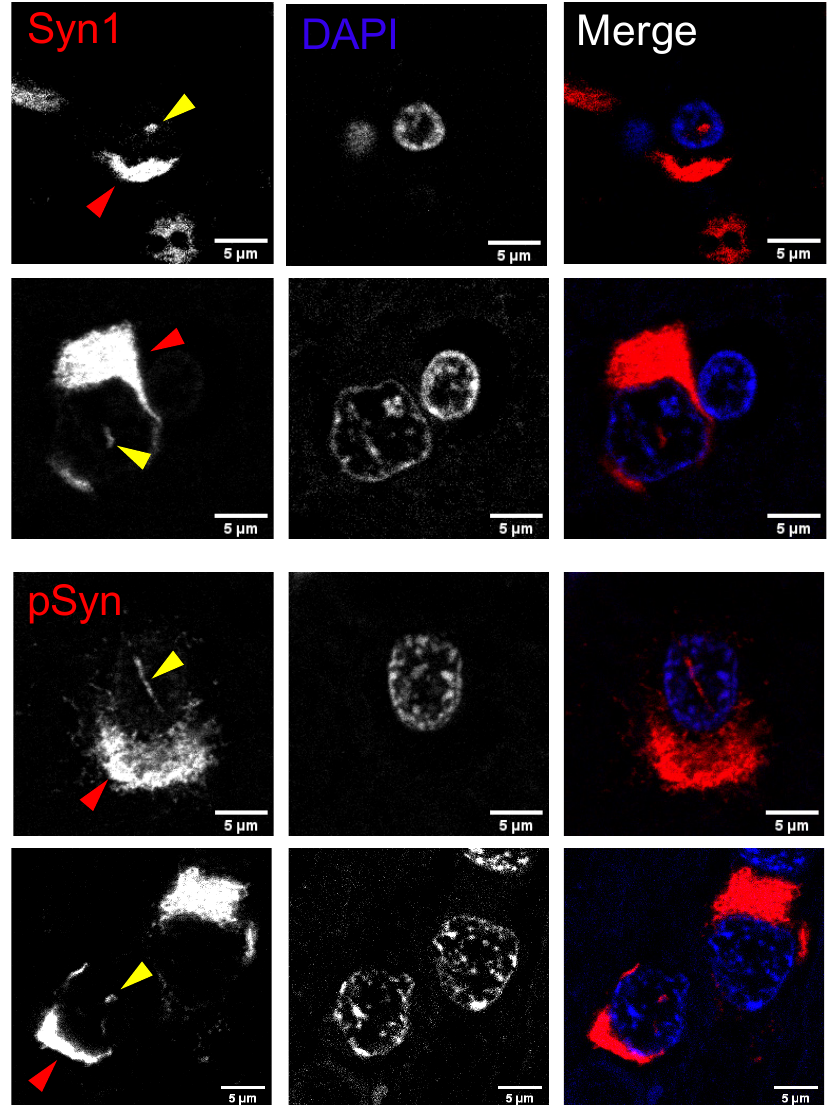
Figure 6. Intranuclear alpha-synuclein aggregates are present in pontine neurons and glia bearing somatic synuclein pathology in human cases of multiple system atrophy. Confocal imaging in fixed tissue from the pons in human cases of multiple system atrophy shows examples of intranuclear alpha-synuclein aggregates (yellow arrowhead) labeled with a total alpha-synuclein antibody (Syn1, top two rows) or a serine-129 phospho-synuclein antibody (pSyn, bottom two rows). Intranuclear aggregates are in glia (top row) and neurons (bottom three rows), as defined by morpho- logical criteria, and in cells that also contain cytoplasmic pathology (red arrowhead). Scale bar: 5 μ m.